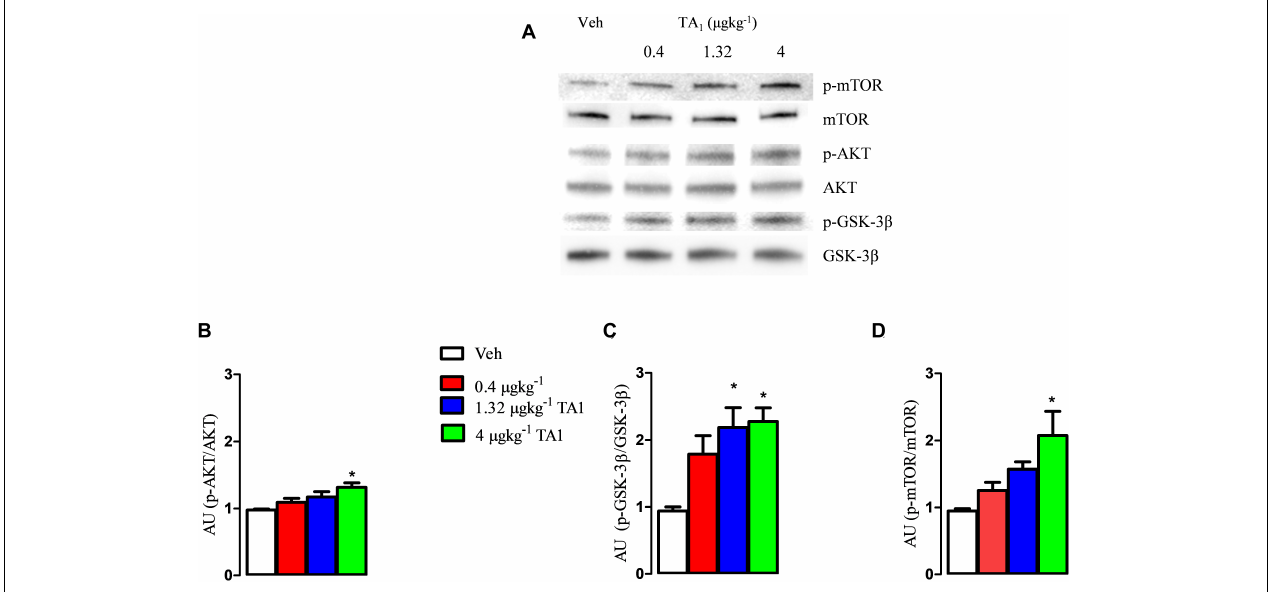
FIGURE 3 | The effects of TA1 on hypothalamic p-PI3K/AKT and p GSK-3 levels. Male CD1 mice received an intraperitoneal injection of either vehicle (Veh) or 0.4, 1.32 and 4 µ gkg − 1 TA1. Hypothalamic levels of p-AKT (B) , p-GSK-3 β (C) , and p-mTOR (D) were assessed 15 min after mice treatment. (A) A representative experiment is shown. (B–D) Densitometric analysis is showed. Results are presented as the mean ± SEM of 3 different experiments; ∗ P < 0.05 vs. Veh. (One-way ANOVA test followed by Tukey Multiple Comparison